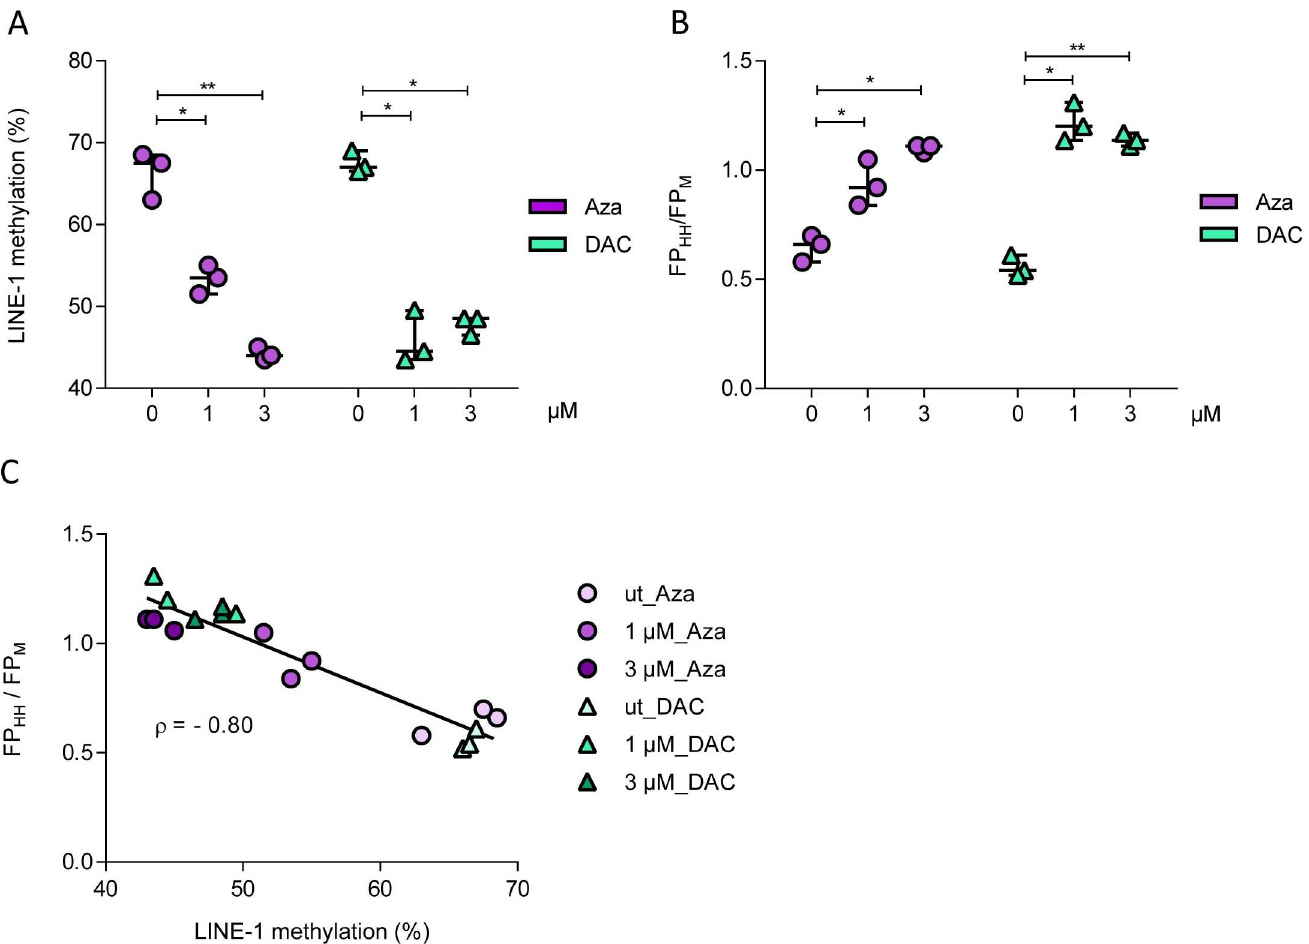
Fig 4. Comparison of the MSFP and LINE-1 assays. (A) Detection of DNA hypomethylation induced by Aza and DAC using the LINE-1 pyrosequencing assay. Three independent experiments were carried out and each data value (circle, triangle) and its median (bar) are shown in a Box- Whisker-Plot. (B) The MSFP assay data present different DNA methylation states as the ratio of the FP HH values to the FP M values. In contrast to the LINE-1 data, a decrease in global DNA methylation (here due to Aza or DAC), results in a higher FP HH value and therefore, in a higher FP HH /FP M ratio. The DNA samples used for the MSFP assay were identicalto those used for the LINE-1 assay. The data represent three independent experiments with technicaltriplicates and each data value (circle, triangle) and its median (bar) presentedas a Box-Whisker-Plot. The statistical differences between untreated and treated groups (Aza or DAC) were determinedusing a Kruskall-Wallis test with Dunn’s multiple comparison test ( * p < 0.05, ** p < 0.01) for both assays. (C) Correlation between the MSFP and LINE-1 assays. Global DNA methylation level in THP-1 cells treated with DNMT inhibitors(n = 18) was determinedusing the MSFP and LINE-1 assays, and the reciprocalcorrelationbetween the methods determined by two-tailedSpearman’s rank correlationtest ( ρ = –0.80).